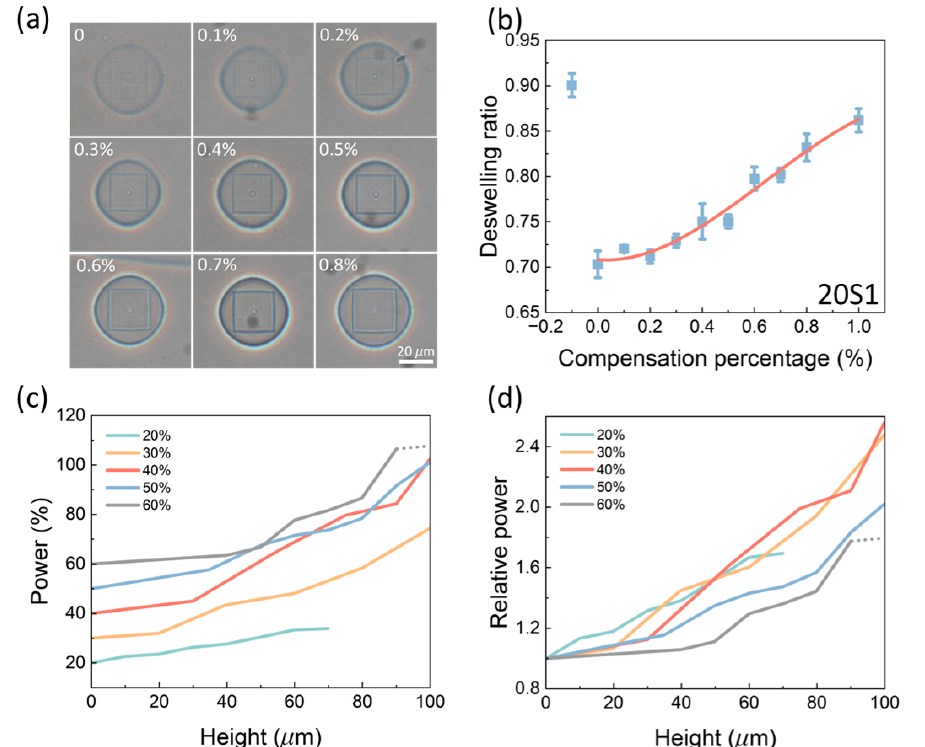
Figure 5. Power compensations obtained from the piecewise-linear approximation. ( a ) Samples compensated by different percentages with an initial laser power of 20%. ( b ) Deswelling ratios and fitting curve for Step 1 of the calibration. ( c ) Power compensation curves for different laser powers along the height. ( d ) Relative power compensations for different laser